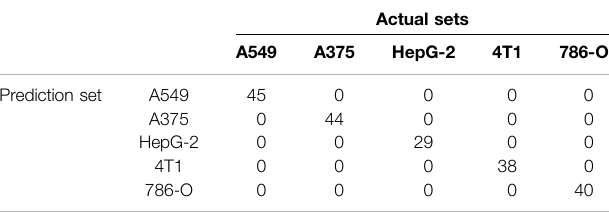
TABLE 4 | Confusion matrix of fi ve cancer cell lines using the SVM classi fi cation